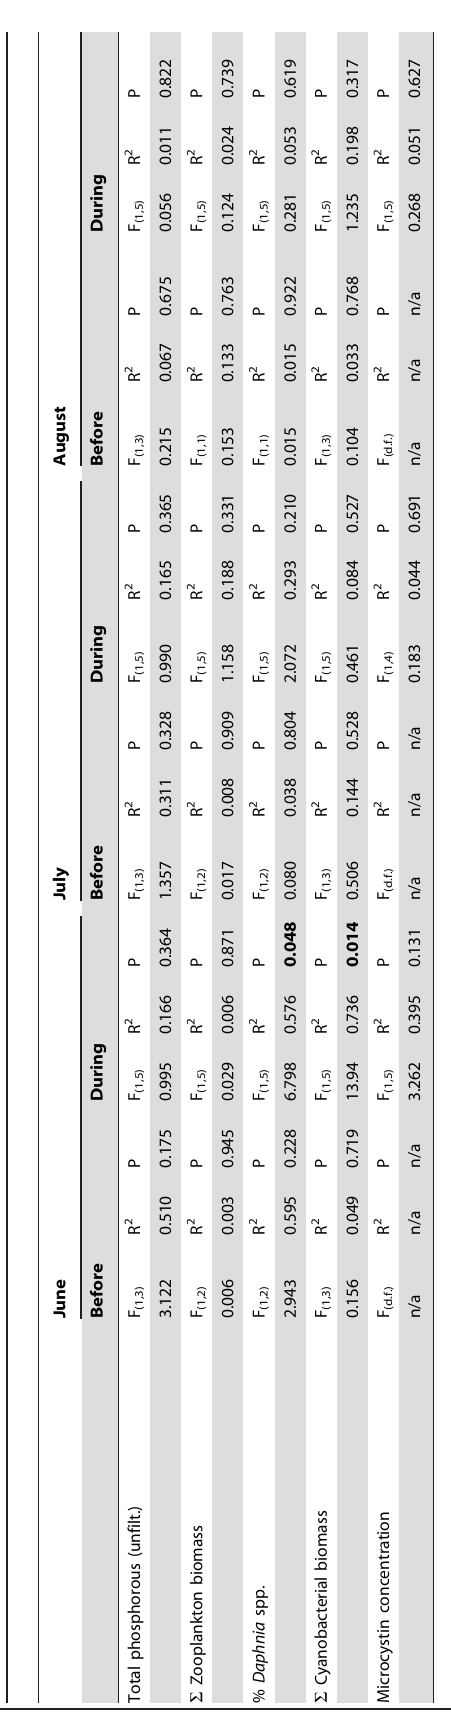
(Table 1, Fig. 3: j–l). Total phosphorous concentrations in the lake